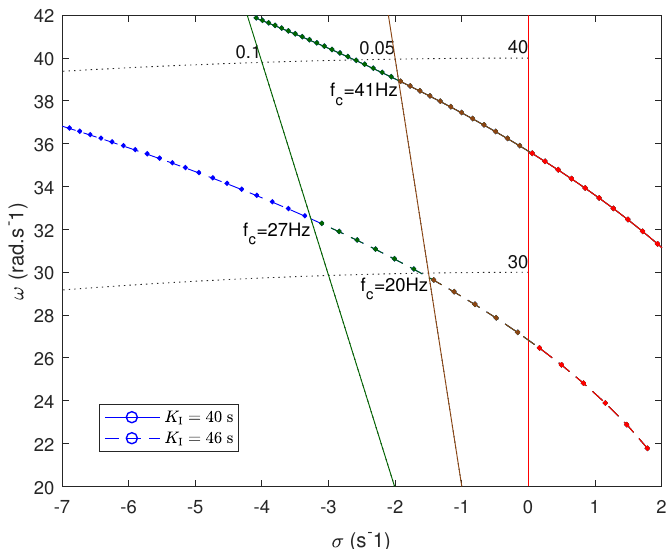
Figure 8. Stability locus of most critical pole showing the minimum value of f c for different values of virtual inertia gains.